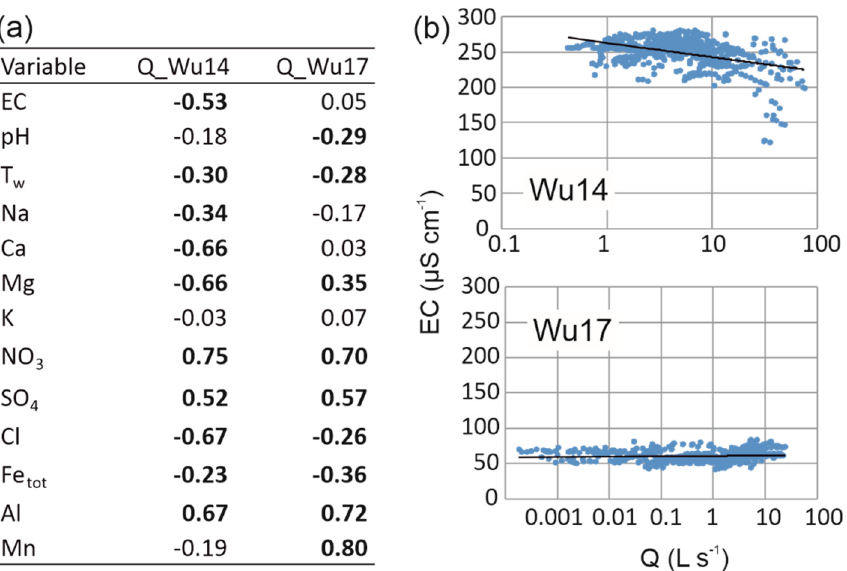
Figure 4. ( a ) Pearson’s correlation coefficients between stream discharge in the Wüstebach (Wu14; N = 93) and control catchments (Wu17; N = 93) and physicochemical properties of stream water in the pre-deforestation period (Sep 2011–Aug 2013). Correlations bolded are significant at p ≤ 0.05. ( b ) Relationship between daily streamflow (Q) and daily electric conductivity (EC) in both catchments in the pre-deforestation period (data points are shown in blue, and the black line indicates a trend line).